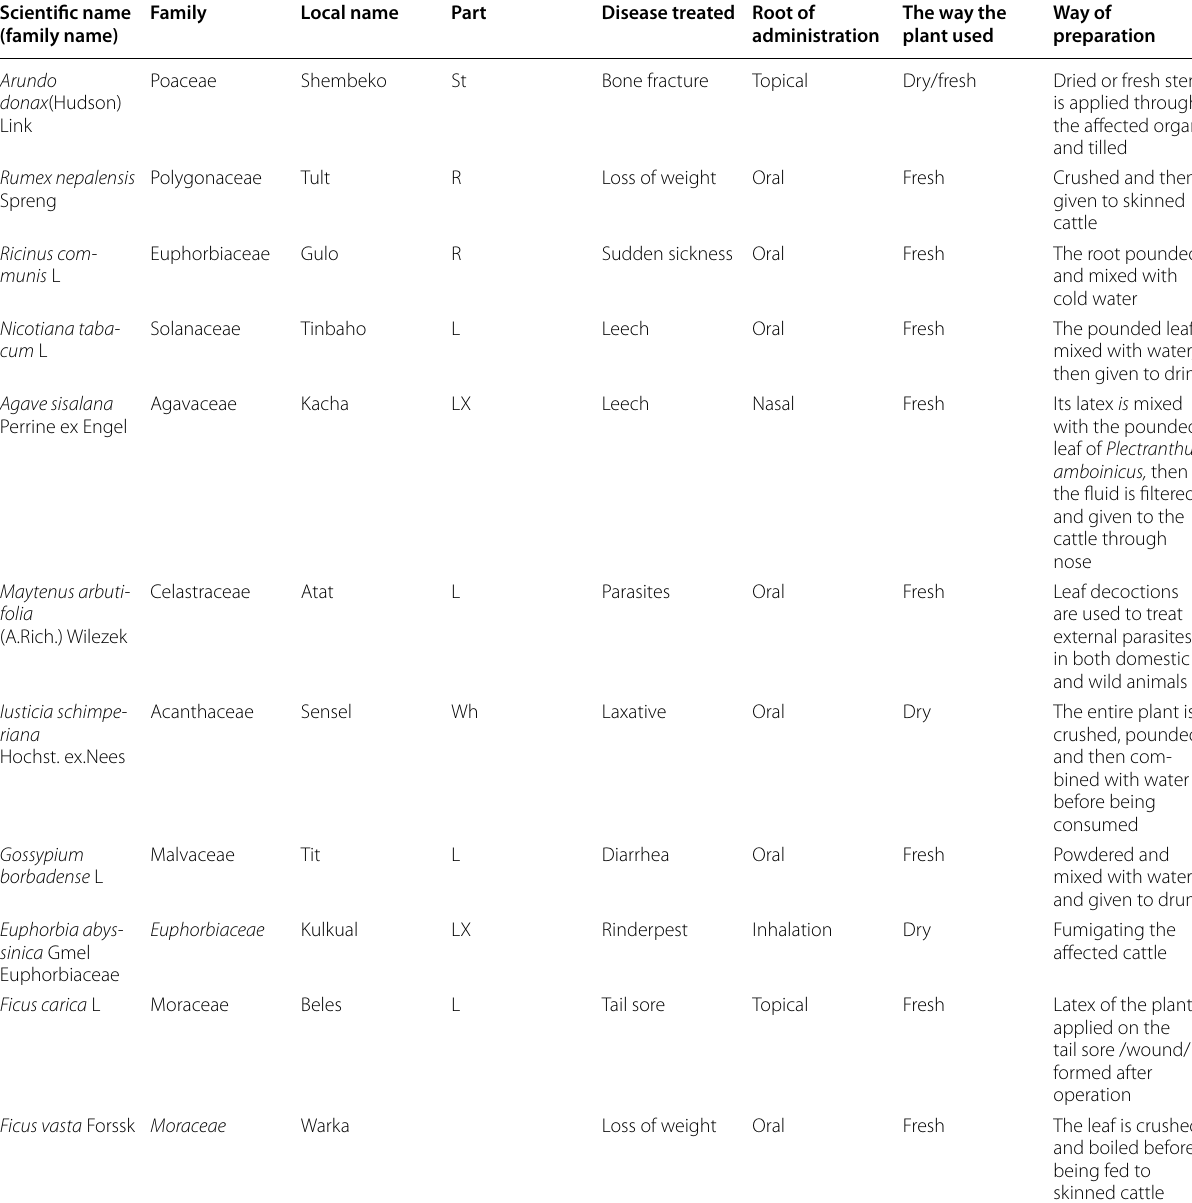
R root, L leaf, SB stem bark, Fr fruit, SD seed, Sh shoot, St stem, Wh whole plant, Br branches, Rh rhizome, Bu bulb, Lx latex